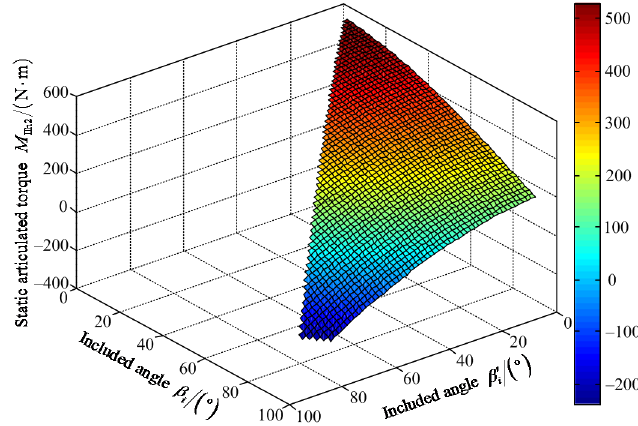
Figure 13. Variable tendency chart of static articulated torque M IIh2 with changes of β i ′ and β i .